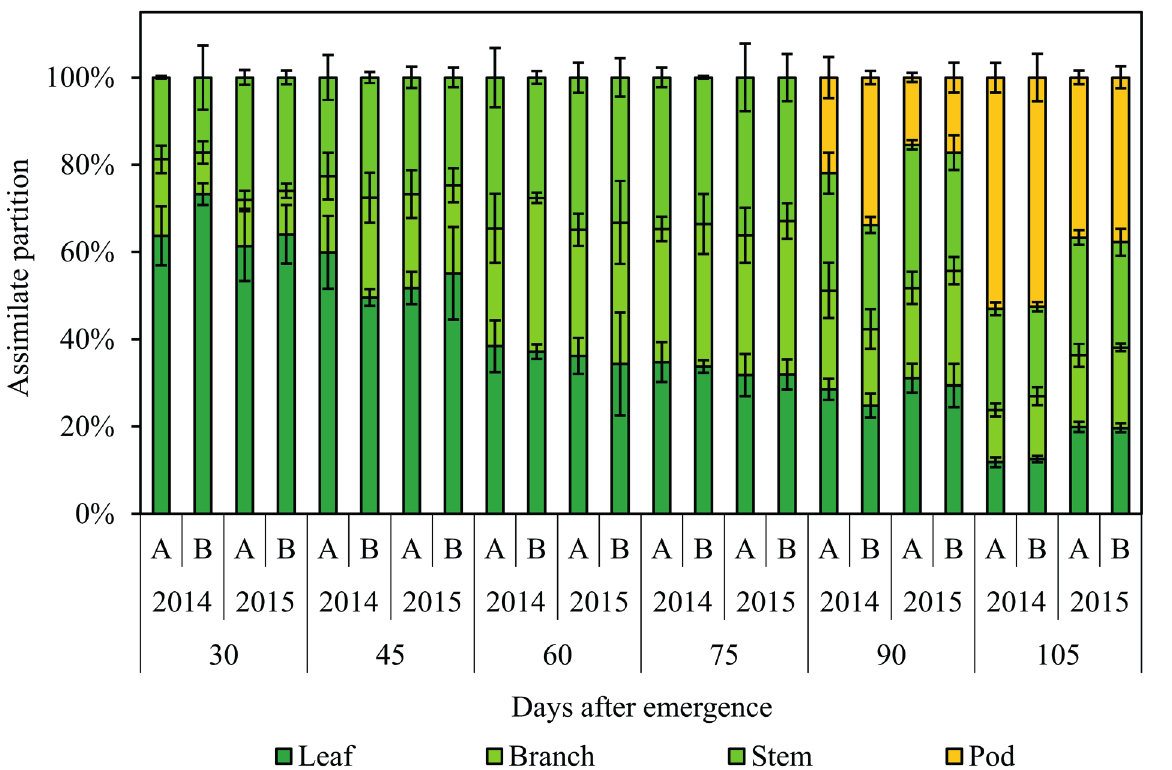
Figure 5 - Assimilate partitioning to different structural components of soybean plants (leaf, branch, stem, and pod) for the cultivars ‘A’ - NA6411 and ‘B’ - TEC6029 in two crop years (2013/2014 and 2014/2015) throughout all evaluation periods in a field experiment in Frederico Westphalen, Brazil. Bars represent the standard deviation of mean values ±